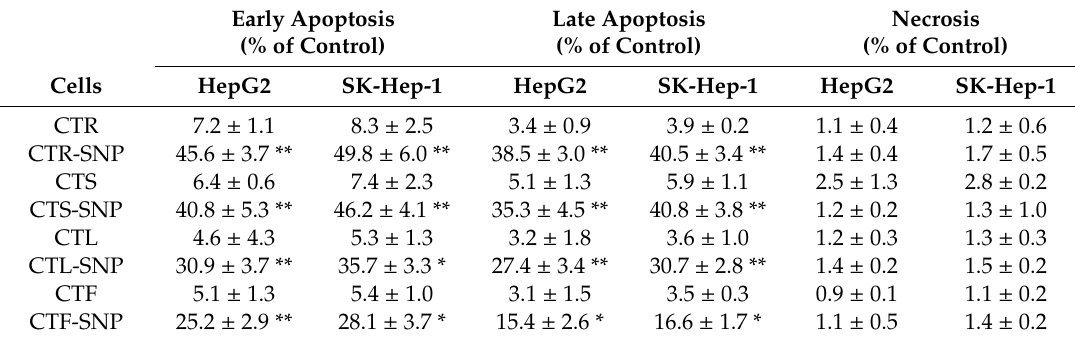
Table 2. Apoptosis of CTR, CTS, CTL and